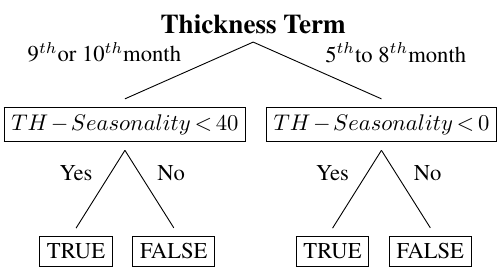
Figure 3. Schematic diagram of the thickness term. Fig. 3. Schematic diagram of the Thickness Term parcel of air over the inversion, contributing to the thunder- storm development. The main sources of a lift mechanism are associated with terrain features, heating and sea